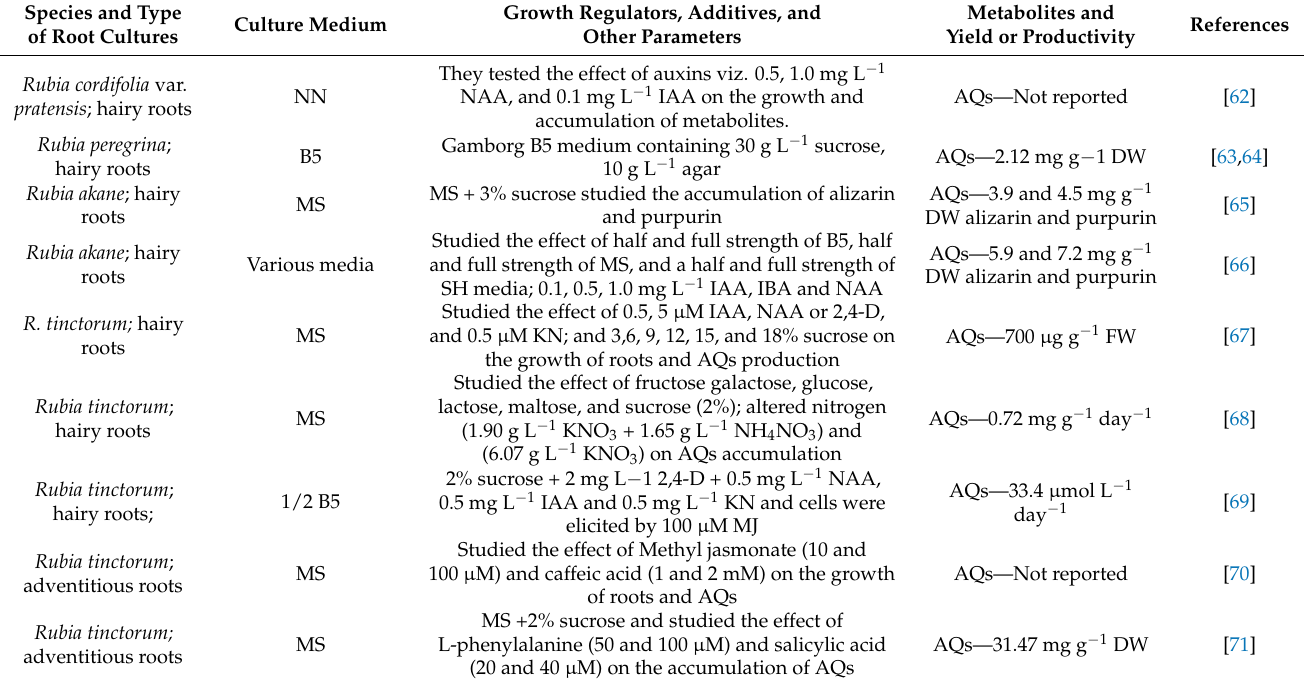
Table 4. Hairy/adventitious root cultures for the production of AQs in Rubia